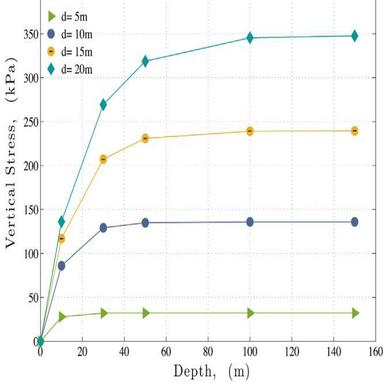
Vertical load expected at the mine as a function of depth and draw-zone diameters.